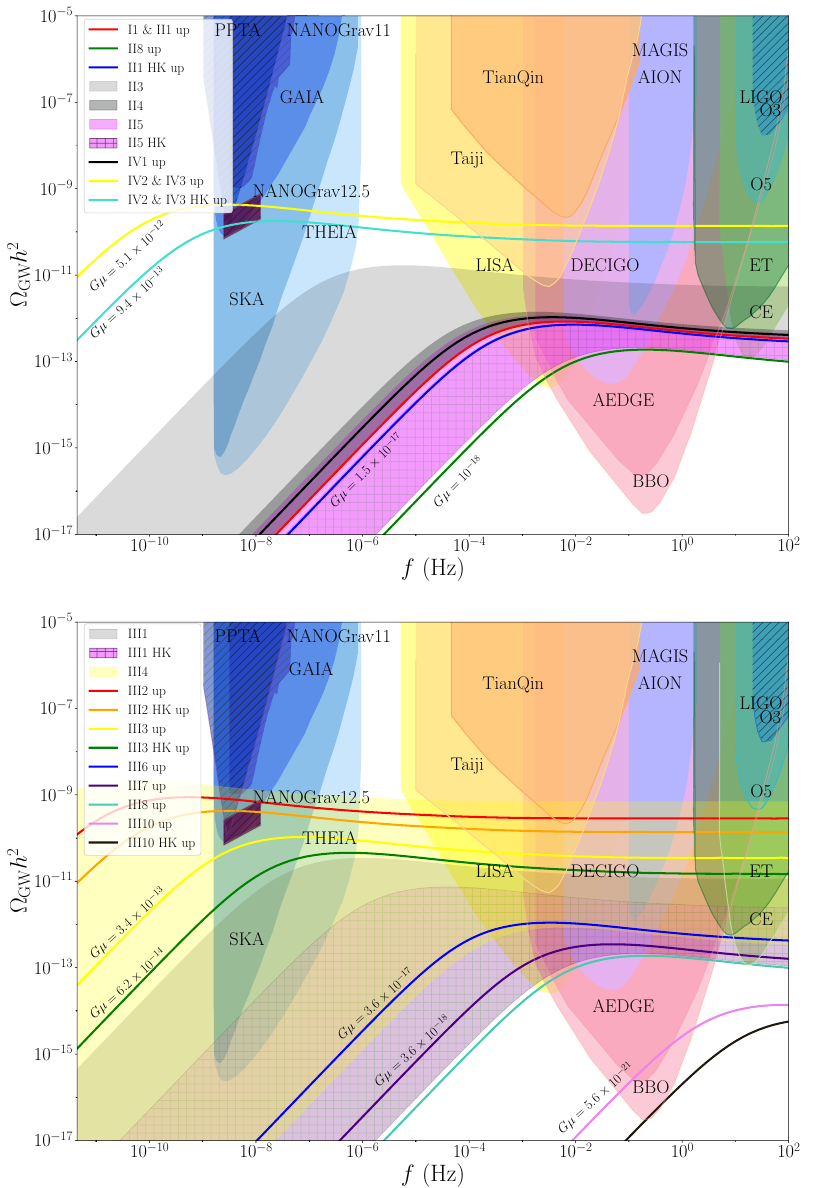
Figure 8 . SGWB predicted from cosmic string networks shown in table 6. The solid coloured lines indicate signal or upper bounds (if it is an upper bound, this is indicated as “up” in the legend) for various type (c) breaking chains. The solid (hatched) coloured regions indicate the range of values of Gµ predicted by the non-observation of proton decay by Super-K (Hyper-K). The SGWB for II3, II4 and II5 consistent with the current Super-K bound are shown in light grey, dark grey, and pink. The yellow hatched region shows the SGWB for II5 consistent with the non-observation of proton decay at Hyper-K. Current (future) experimental limits are shown by hatched (solid) regions. The dark purple rhomboidal region shows the signal region observed by NANOGrav